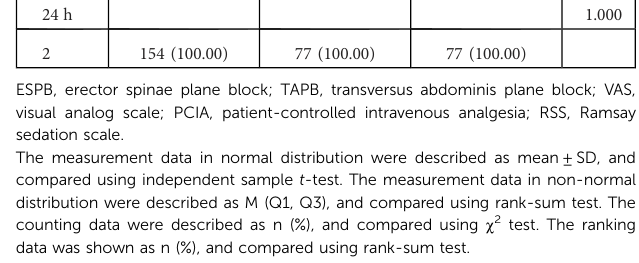
TABLE 2 Comparison of postoperative analgesia and opioids consumption between the two groups at observation time points after the operation. Variables Total ( n